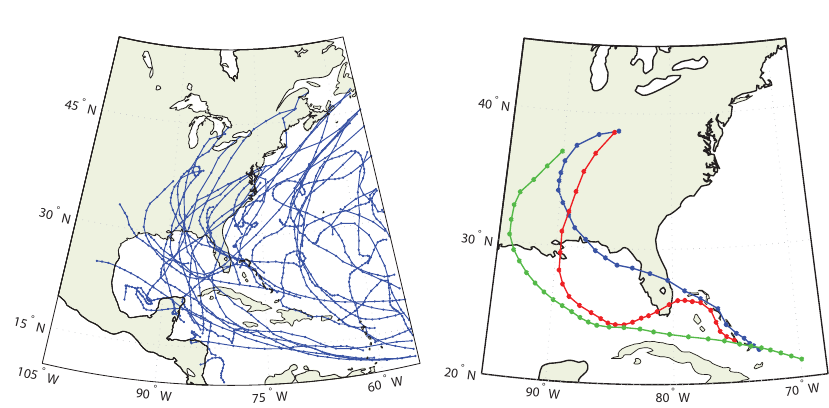
Figure 9: Left: Data set. Right: Hurricanes Erin 1995 (blue), Katrina 2005 (red), and Rita 2005